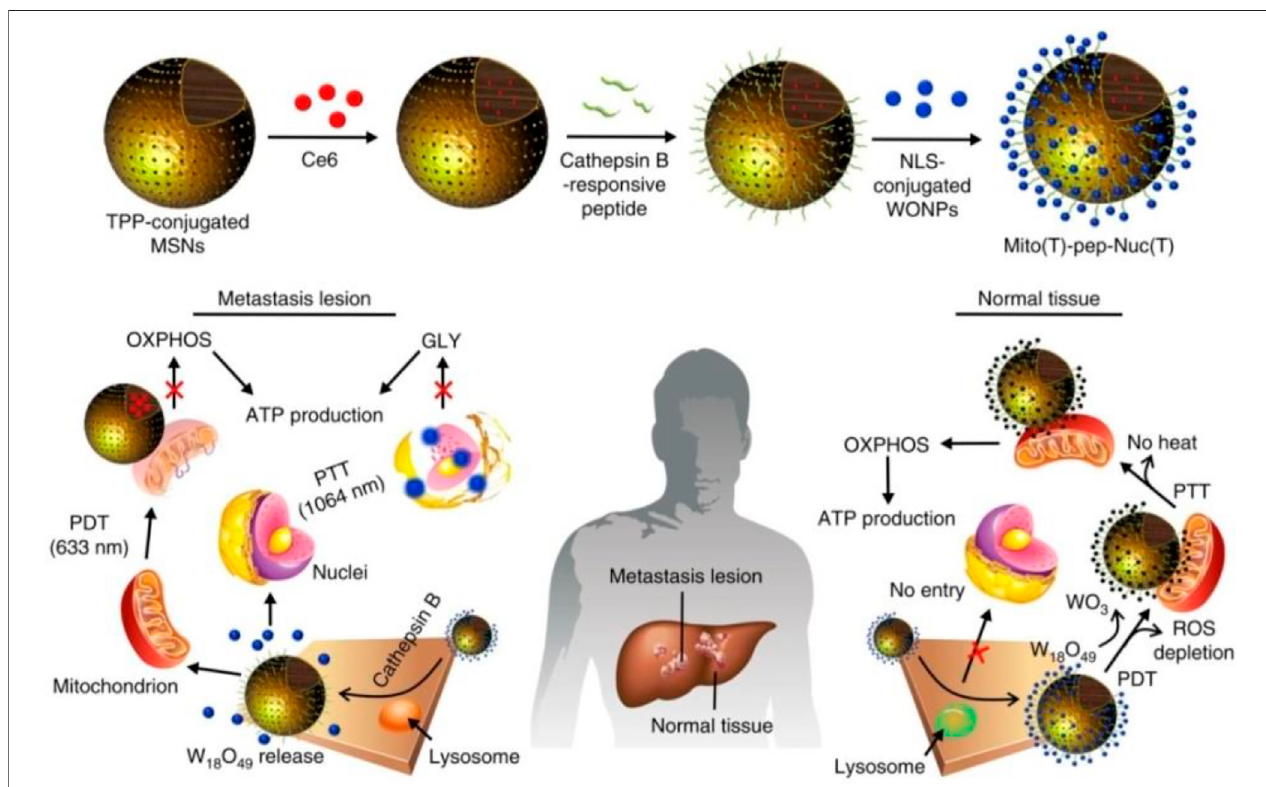
FIGURE 5 | Working principle of Mito (T)-pep-Nuc (T) (Huo et al., 2019).